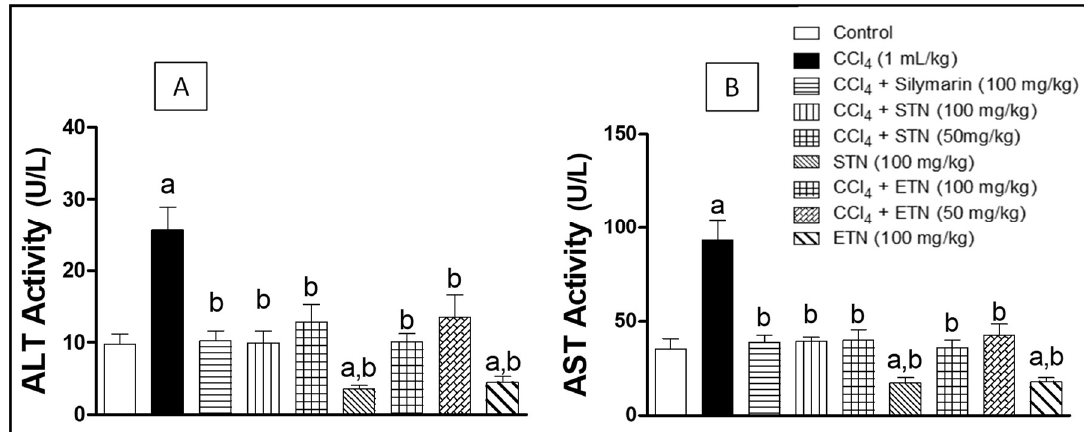
Figure 2. Effect of ETN and STN on ALT (Panel A ) and AST (Panel B ) serum activities in rats subjected to chronic CCl 4 intoxication. * Data are the mean ± SD ( n = 10). a or b Significantly different from control or CCl 4 group respectively at p < 0.05 using ANOVA followed by Tukey-Kramer as a post-hoc test.